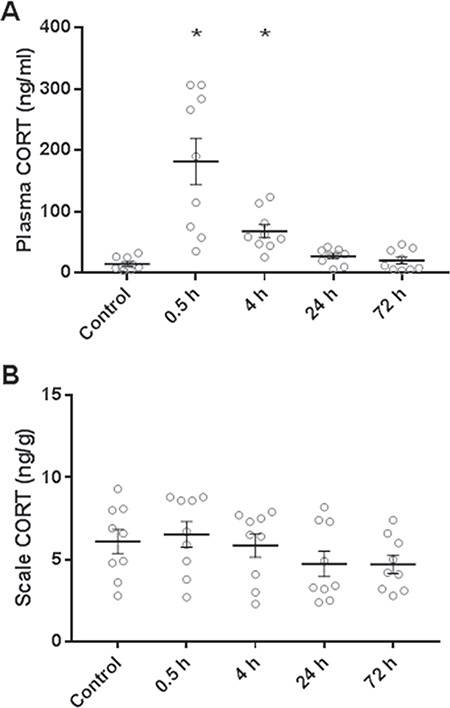
Effects of an acute stressor on plasma cortisol (CORT) and scale cortisol content over a period of 72 h. (A) Cortisol levels in plasma. (B) Cortisol levels in scales. Fish were exposed to air for 2 min before their return to their holding tank and sampling between 30 min and 72 h. Significantly increased levels compared to an unstressed control group are indicated by asterisks (n = 9). Data are mean ± SEM